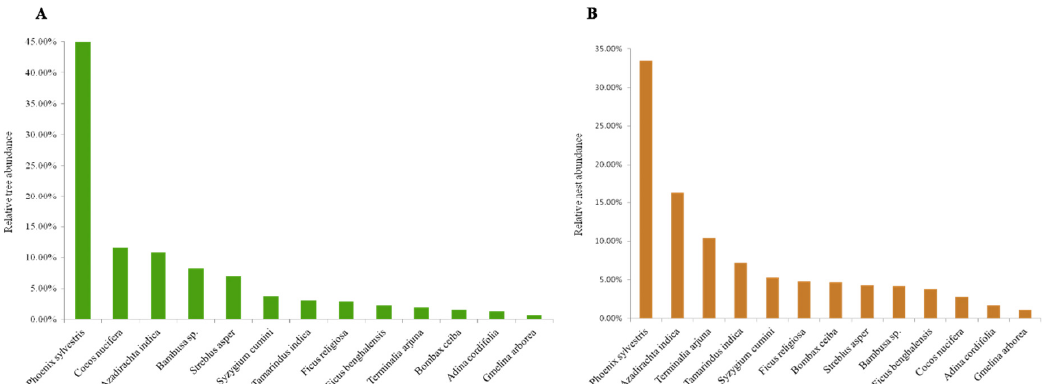
Figure 4. Histograms representing: A. relative tree abundance and B. relative nest abundance recorded in the seven study sites of Gangajalghati